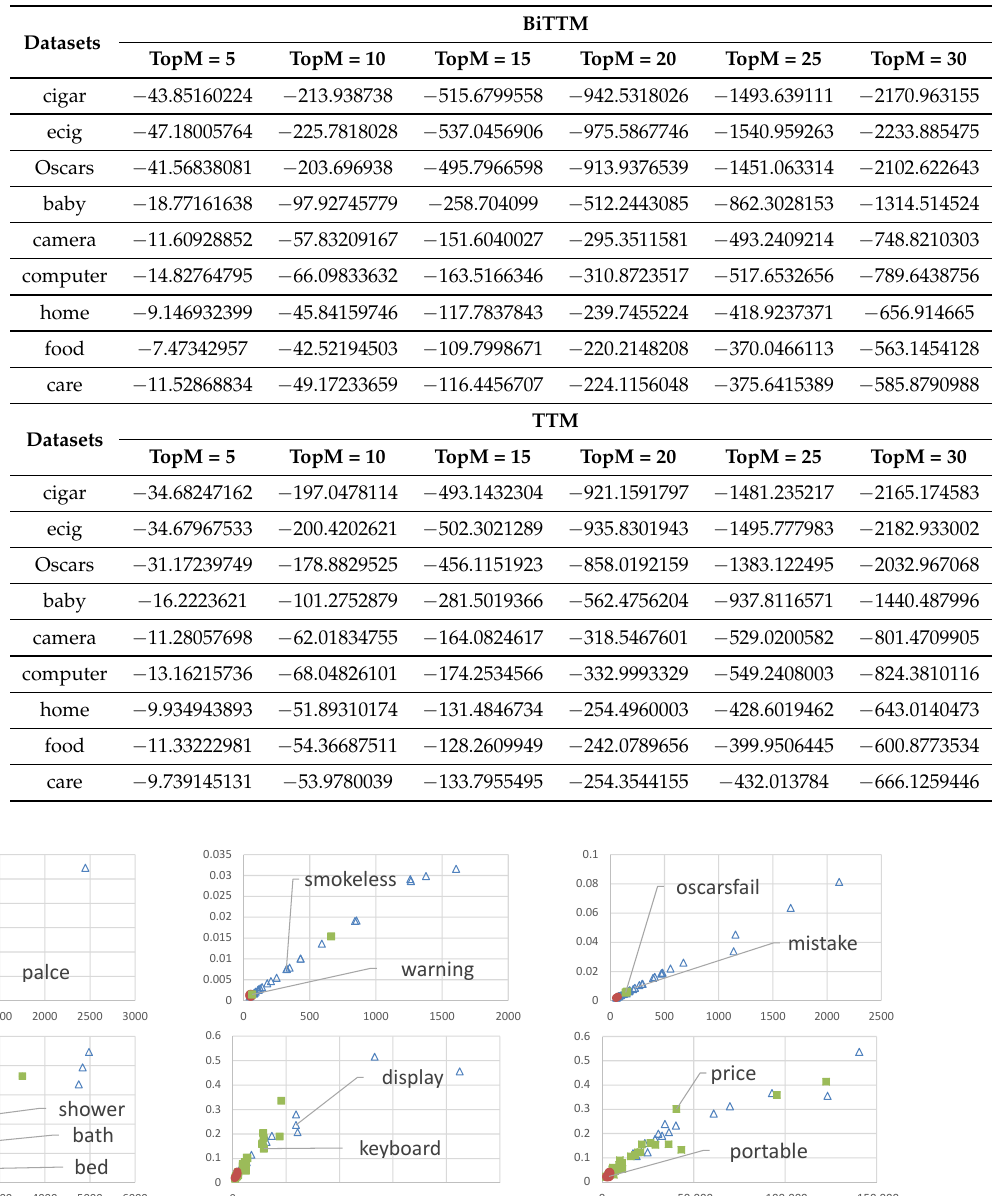
Table 4. Topic coherence.